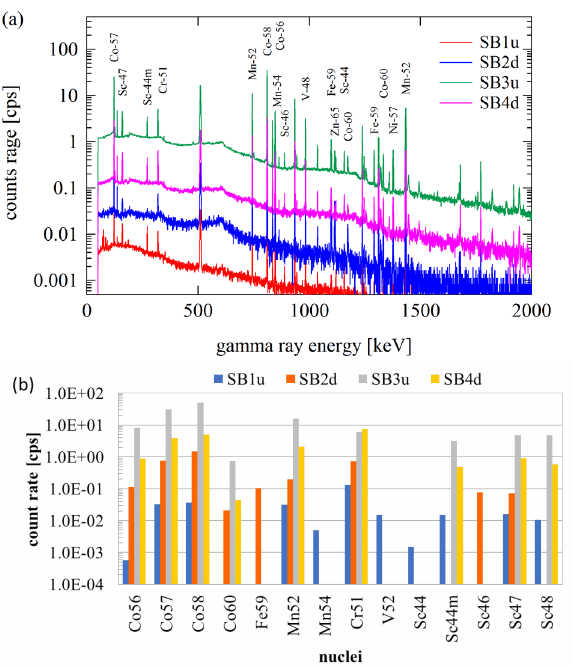
Fig. 10. Gamma-ray spectra and histograms of nuclei produced in copper sample pieces set on titanium sleeves of ceramics ducts.